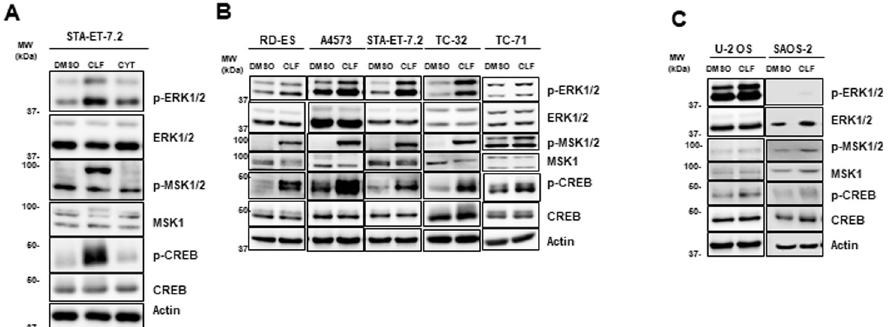
Fig 5. Phosphorylation changes after treatment for different ES and OS cell lines. (A) Cytarabine’s effect on STA-ET.7.2 cells compared to the clofarabine treatment. Cells were treated with clofarabine, cytarabine or DMSO. Immunoblot analysis showed cytarabine did not alter phosphorylation of ERK1/2, MSK1/2 and CREB; (B) Immunoblot results of phosphorylation changes after clofarabine treatment of different ES cell lines; clofarabine caused increased phosphorylation of ERK1/2, MSK1/2 and CREB in all five ES cell lines; (C) Clofarabine treated OS cell lines did not show significant increase in phosphorylation of ERK1/2, MSK1/2 and CREB. Actin was used as the loading control for all experiments. (CLF: Clofarabine, CYT: Cytarabine).